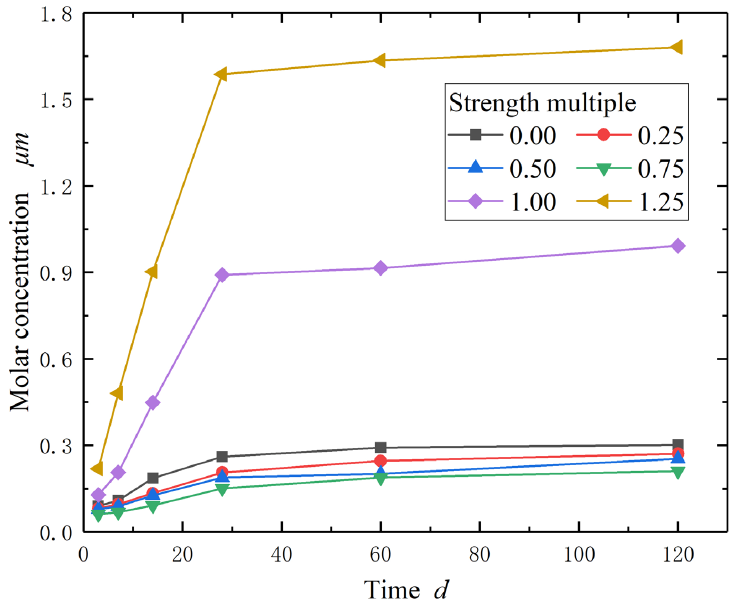
Figure 10. Curves demonstrating the amount of Pb 2+ leaching versus stresses conditions (particle size 1.0